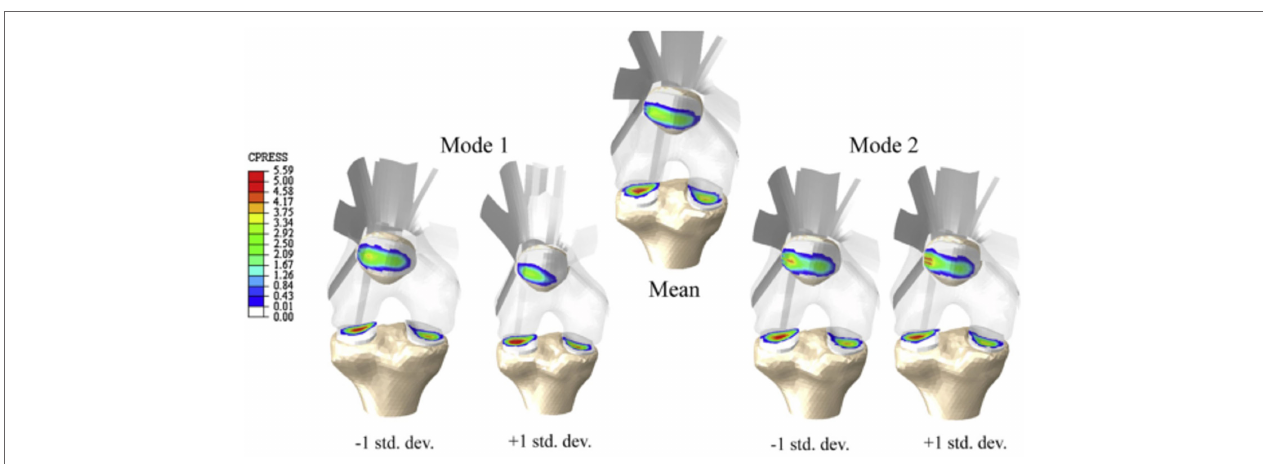
Frontiers in Bioengineering and Biotechnology |